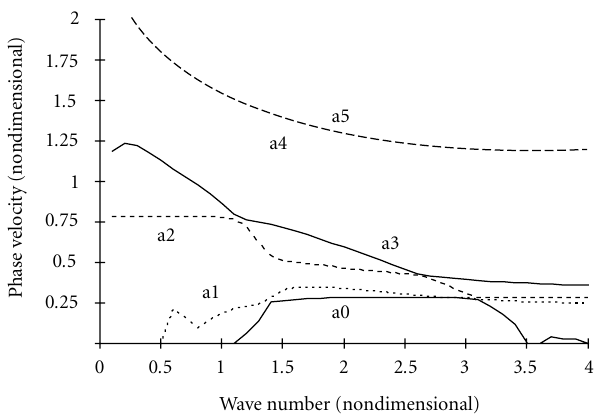
Figure 8.1. Dispersion of the first six flexural modes for τ 0 = 2 . 10 − 7 second and τ 1 = 4 . 10 − 7 second.